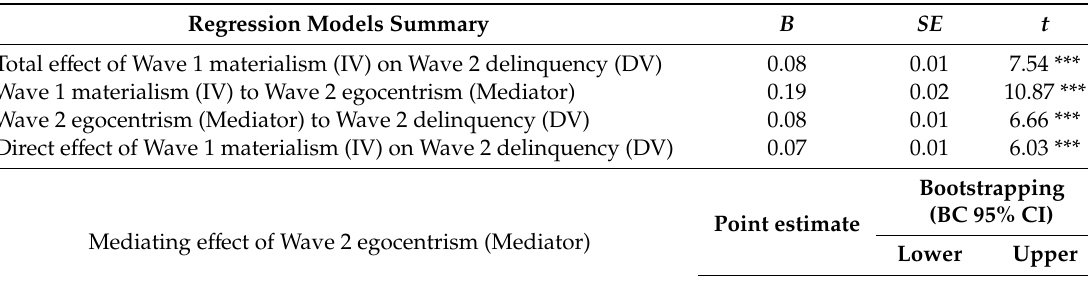
Table 5. Mediating e ff ect of Wave 2 egocentrism (the mediator) for the e ff ect of Wave 1 materialism on Wave 2